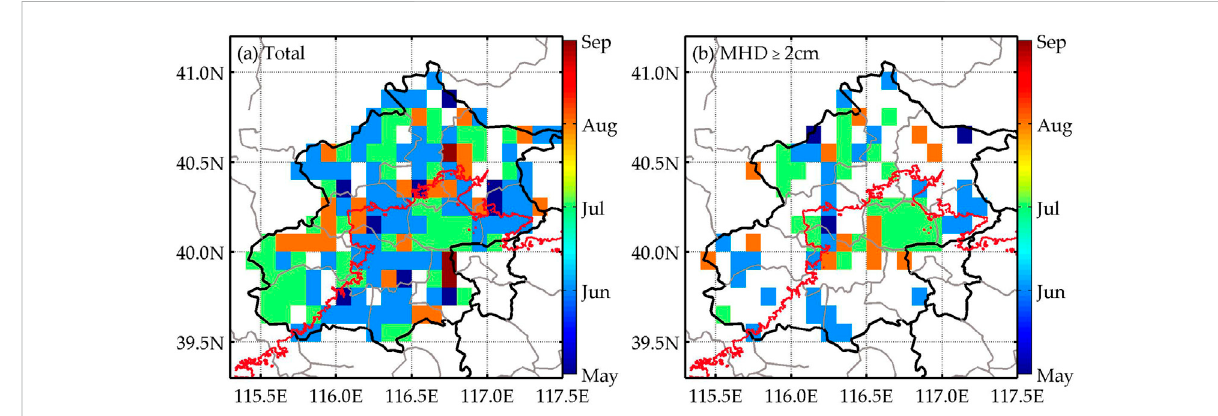
FIGURE 7 Spatial distributions of the month when hail is most frequent in Beijing from 1980 to 2021: (A) . Total hail events; (B) . Hail events with an MHD equal to or larger than 2 cm.